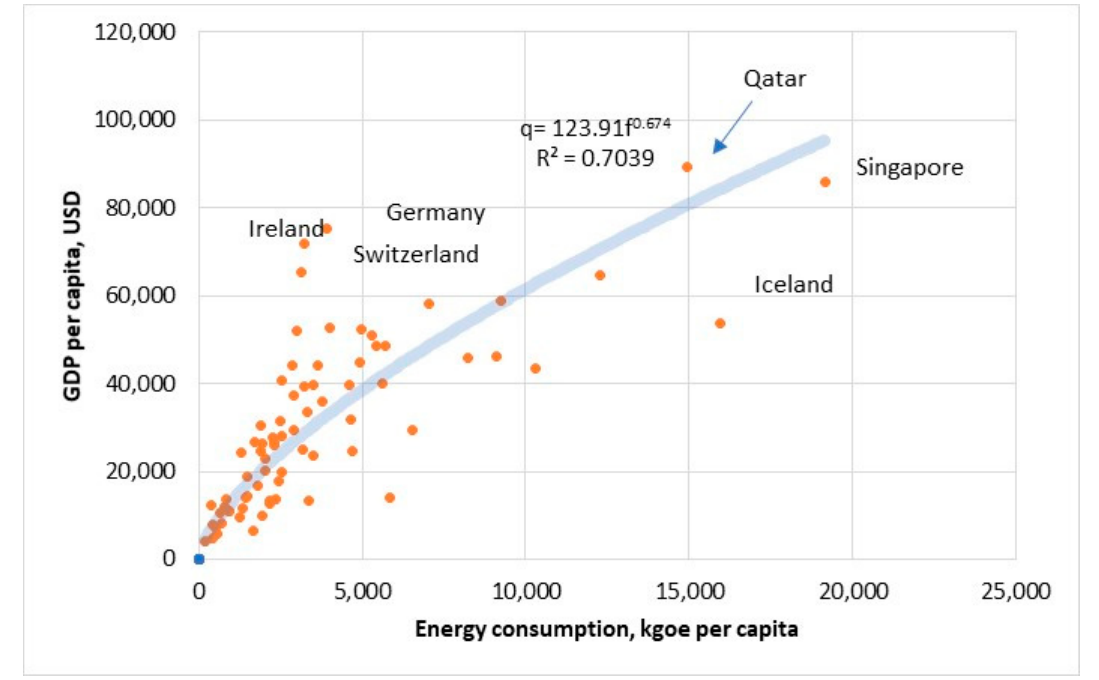
Figure 5. The relationship between economic productivity and per capita consumption of energy resources in national economies (2016). Source: calculated by the authors based on [51,54–57].